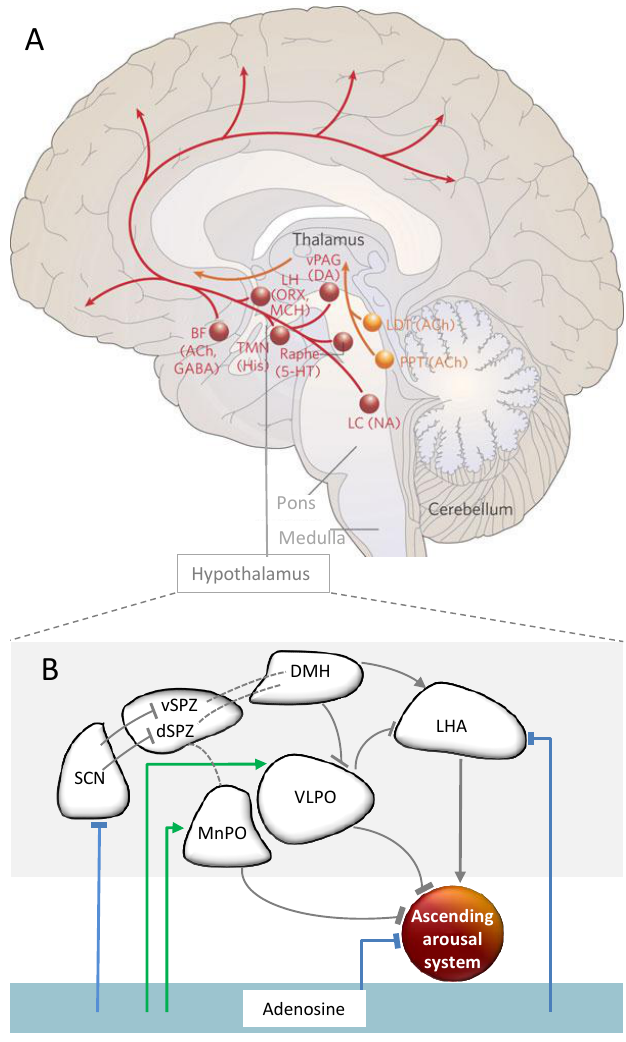
Figure 4. Hypothalamic regulation of the ascending arousal system and the impact of adenosine. ( A ) The ascending arousal system. One of the main pathways ( red ) activating the cortex arises from neurons in the monoaminergic cell groups, including the locus coeruleus (LC) containing noradrenaline (NA), the dorsal and median raphe nuclei containing serotonin (5-HT), the A10 cell group containing dopamine (DA), and the tuberomammillary nucleus (TMN) containing histamine (His). This pathway receives contributions from peptidergic neurons in the lateral hypothalamus (LHA) containing orexin (ORX) or melanin-concentrating hormone (MCH), and from basal forebrain (BF) neurons that contain γ -aminobutyric acid (GABA) or acetylcholine (Ach). The red pathway activates the cerebral cortex to facilitate the processing of inputs from the thalamus. Orange lines represent input to the thalamus originating from cholinergic (ACh) cell groups in the upper pons, the pedunculopontine (PPT) and laterodorsal tegmental nuclei (LDT). Figure and legend modified from a previous work [81]. ( B ) Hypothalamic and adenosinergic arousal modulation. The SCN innervates by GABA-ergic neurons the ventral supraventricular zone. The latter projects to the dorsomedial hypothalamus (DMH), in turn providing glutamatergic input to the orexin-containing neurons in the lateral hypothalamus (LH). These finally target the locus coeruleus (LC), a major player in the ascending arousal system [87]. The ascending arousal system is inhibited by GABA-ergic input of the ventrolateral and median preoptic area (VLPO and MnPO), and in part by adenosine. Adenosine acts inhibitory ( blue lines) via A 1 or disinhibitory ( green lines) via A 2A receptors on several structures within this network. Striped lines show neural projections of which implicated neurotransmitters are currently unknown.